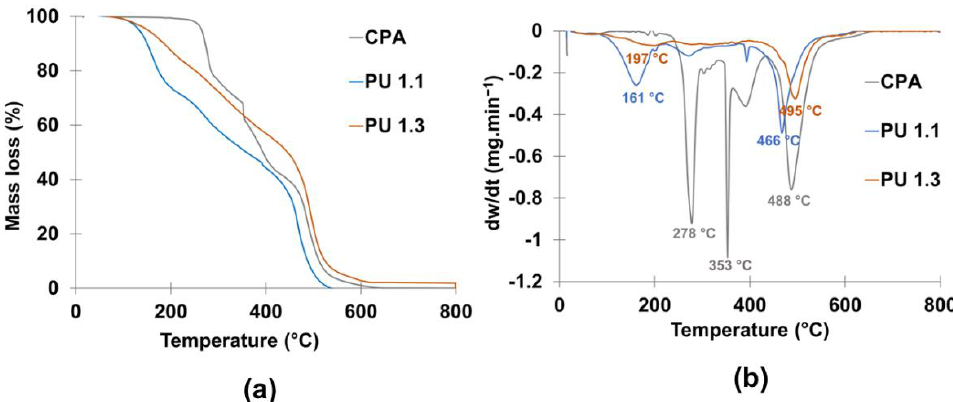
Figure 6. ( a ) TGA curves of PU 1.1, PU 1.3, and CPA, ( b ) Derivatives of mass loss (dw/dt) of PU 1.1, PU 1.3, and CPA .